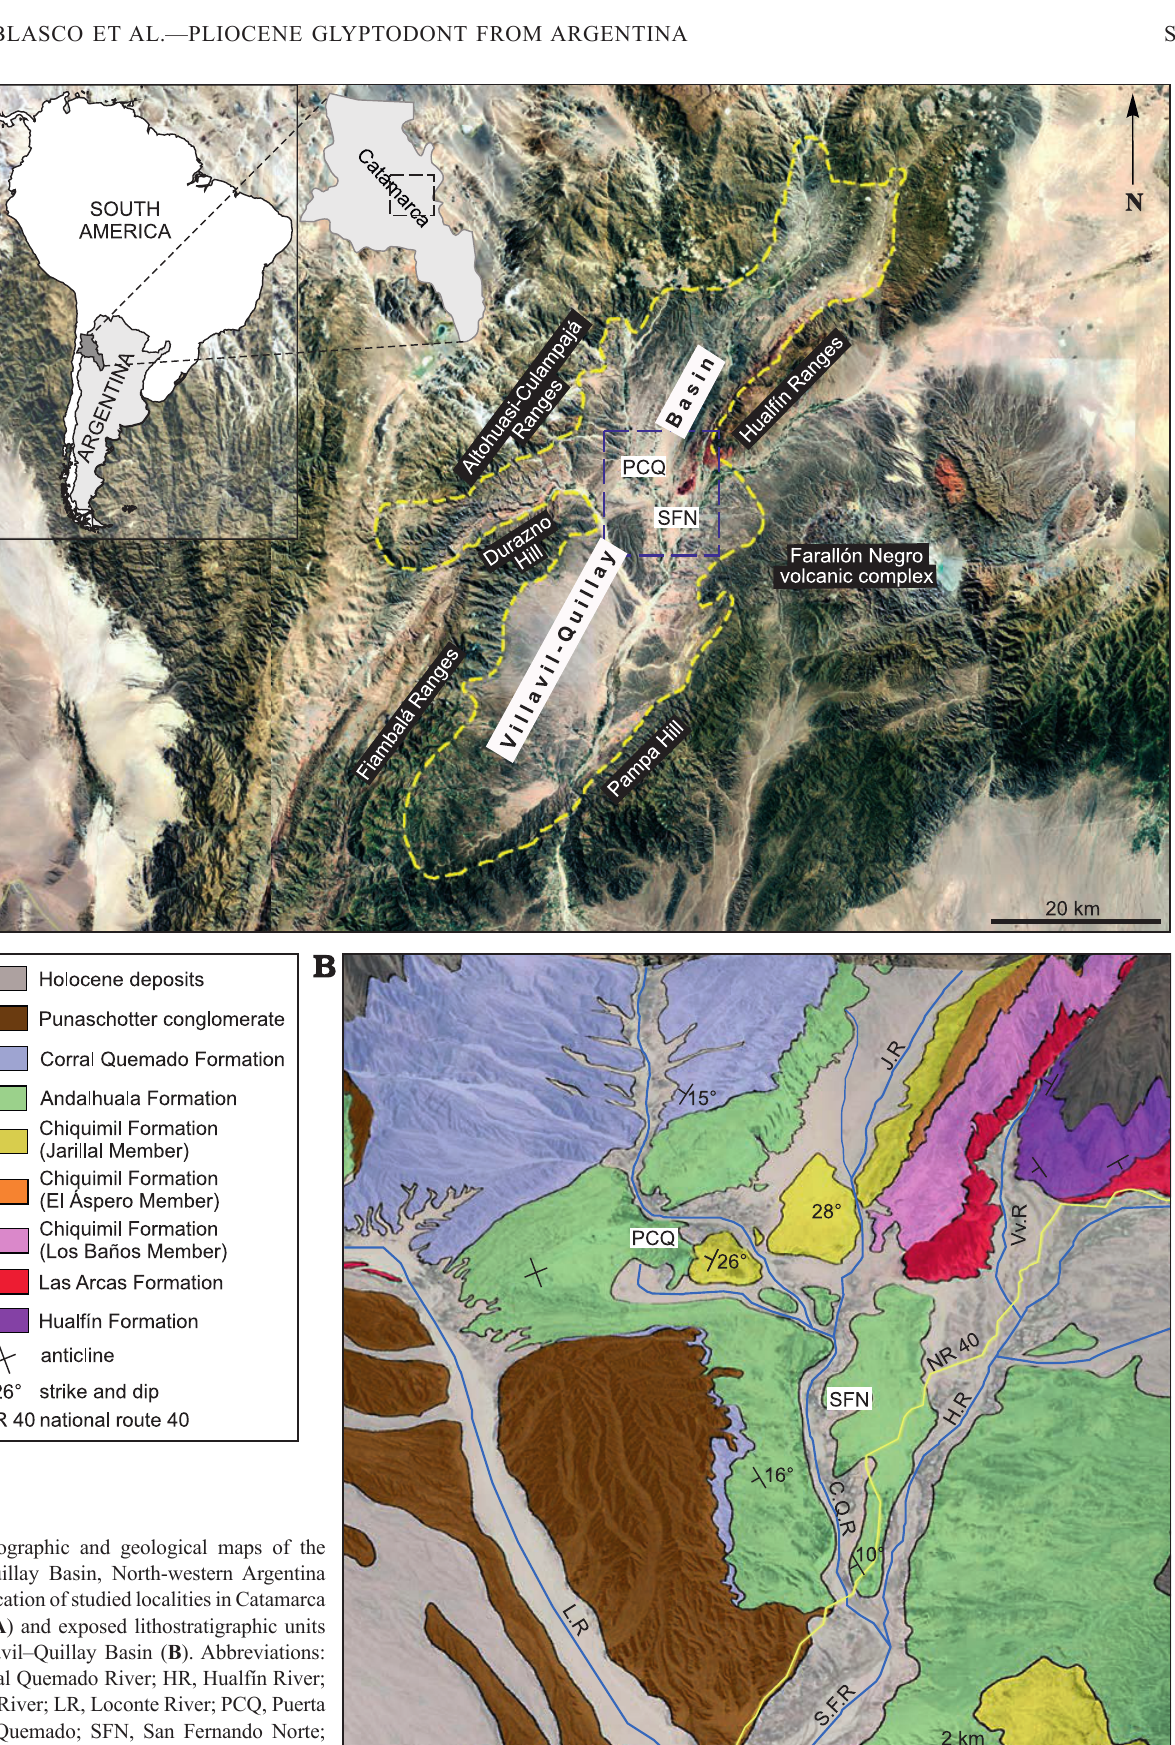
Fig. 1. Geographic and geological maps of the Villavil–Quillay Basin, North-western Argentina showing location of studied localities in Cata marca Province ( A ) and exposed lithostratigra phic units in the Villavil–Quillay Basin ( B ). Abbreviations: CQR, Corral Quemado River; HR, Hualfín River; JR, Jarillal River; LR, Loconte River; PCQ, Puerta de Corral Quemado; SFN, San Fernando Norte; VvR, Villavil